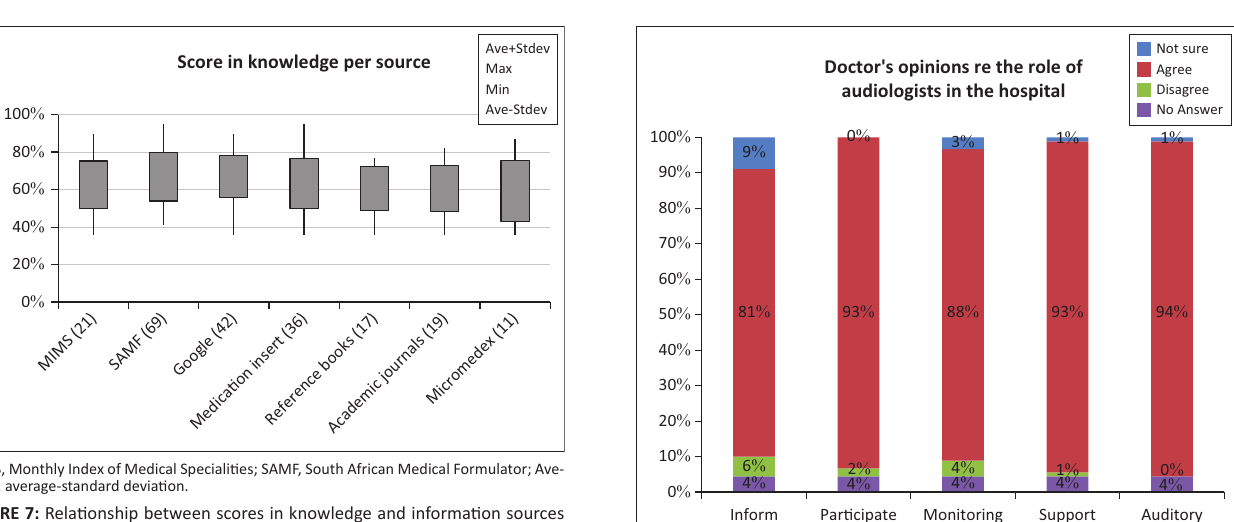
FIGURE 7: Relationship between scores in knowledge and information sources consulted.